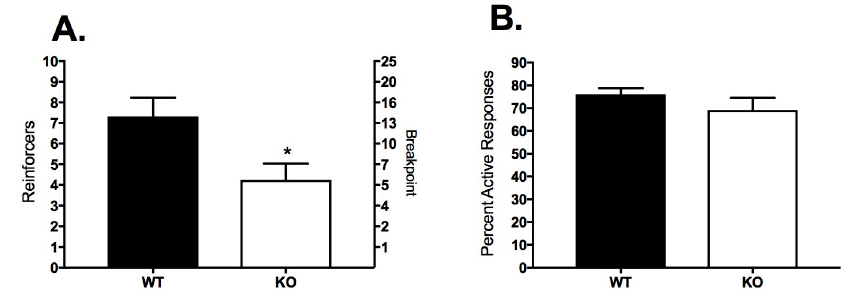
Figure 3. Responses and reinforcers earned during the progressive ratio (PR) schedule in WT ( n = 9; filled bars) and CB1KO ( n = 12; open bars) mice. Bars represent mean ± SEM. ( A ) Left y -axis depicts the reinforcers earned; right y-axis depicts the breakpoint associated with each reinforcer; ( B ) Mean percent of total responses made in the active port. * p < 0.05.